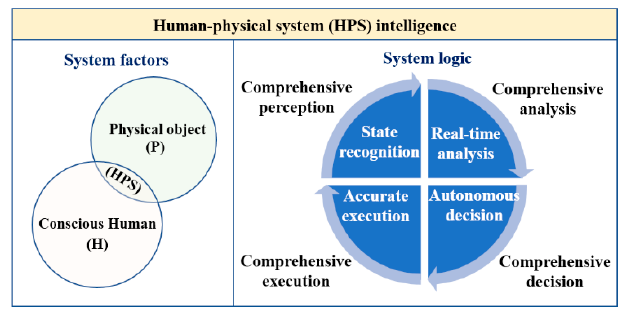
Figure 6. HPS intelligence (Type II).